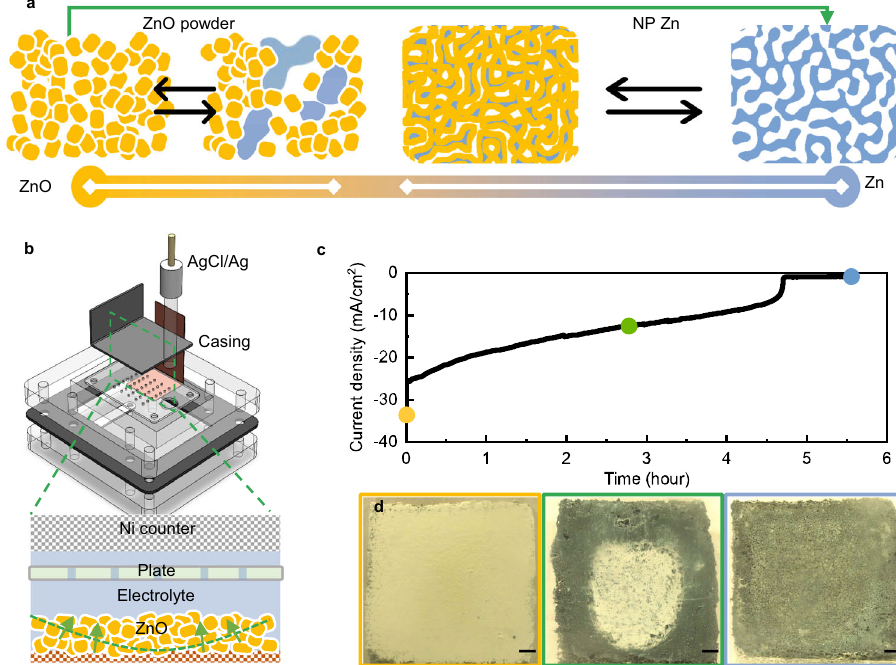
Fig. 1 Electrochemical investigation on the transition between Zn and ZnO. a An illustration of the different paths of transition with pure ZnO (yellow) on the left and pure Zn (blue) on the right. In a ZnO powder anode, the transition (black arrows on the left) is between the powder and clusters of Zn metal, whose non-uniform distribution limits the utilization of the Zn mass to <30% (a range marked with a white line at the bottom scale). Instead, the improved transition (the green arrow) takes the ZnO powder to NP Zn, which can then be cycled stably at >40% DoD (black arrows on the right), as highlighted similarly by the corresponding white line at the bottom scale. b The electrochemical cell designed for the improved transition through an electrochemical reduction, with the assembled electrolyte chamber highlighted at the bottom. The green arrows indicate the direction of the transition and the green dashed line the reaction front. c A typical chronoamperometric curve of the reduction. d Photos of the sample at the three stages of the reduction as labeled in c . The scale bars are 1 mm.